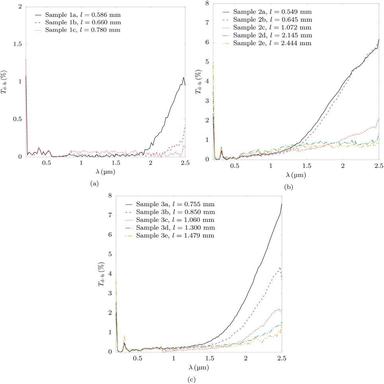
Directional–hemispherical transmittance for samples made of: (a) material 1 (commercial samples), (b) material 2 (in-house prepared samples sintered at 1400◦C) and (c) material 3 (in-house prepared samples sintered at 1500◦C).